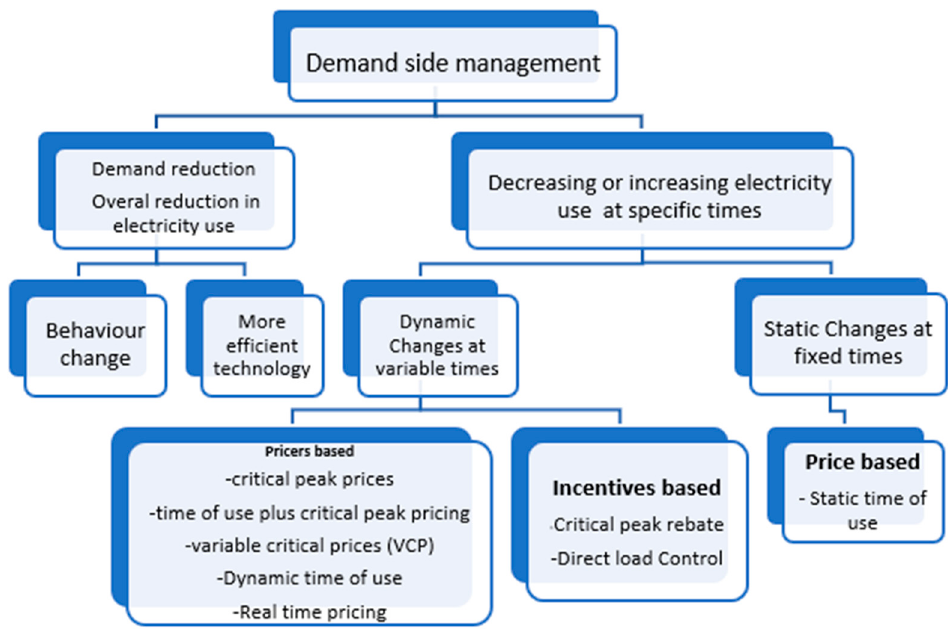
Figure 2. Demand side management and DR solutions (Adapted from Source: [1,36]).